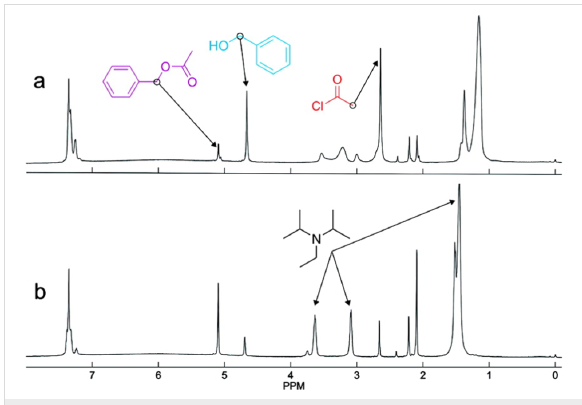
Figure 7: Acetylation of benzyl alcohol. Spectra at (a) 9 s and (b) 3 min. Stoichiometry: benzyl alcohol/DIPEA/acetyl chloride 1:1:1.2. Reproduced with permission from reference [44]. Copyright 2009 The American Chemical Society.